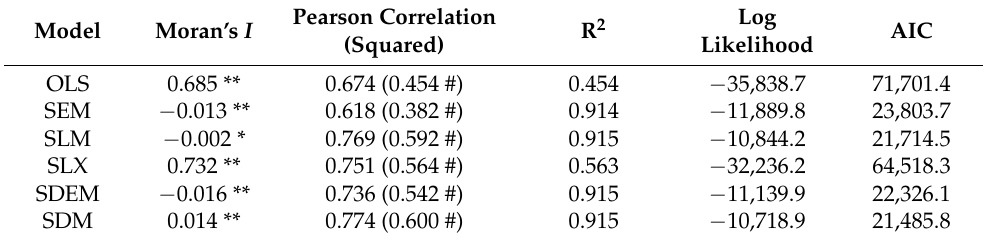
Table 4. Comparison of goodness of fit between different models.